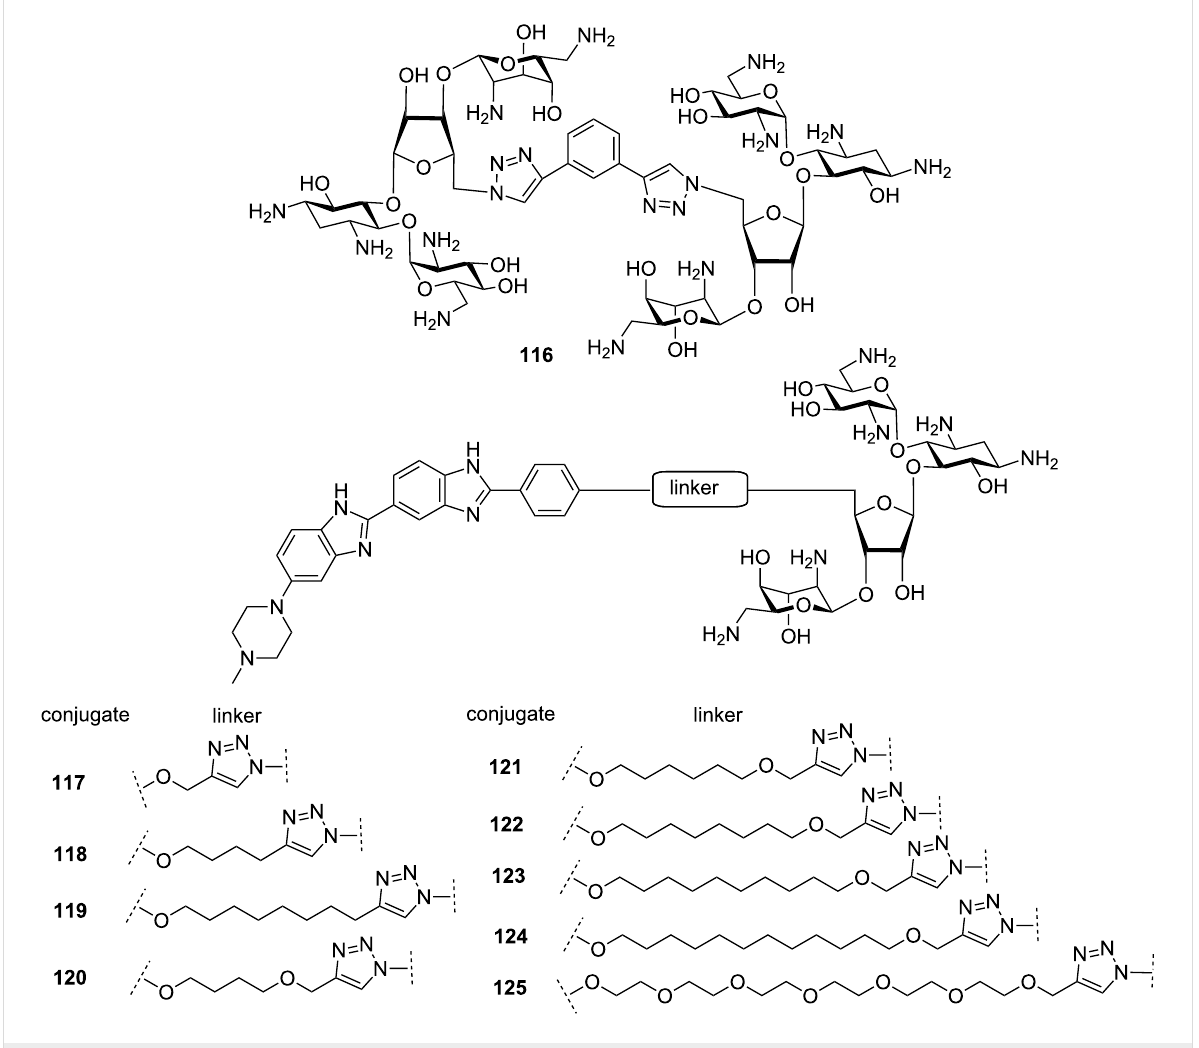
Figure 19: Chemical structures of triazole linked neomycin dimers and neomycin–bisbenzimidazole conjugates.